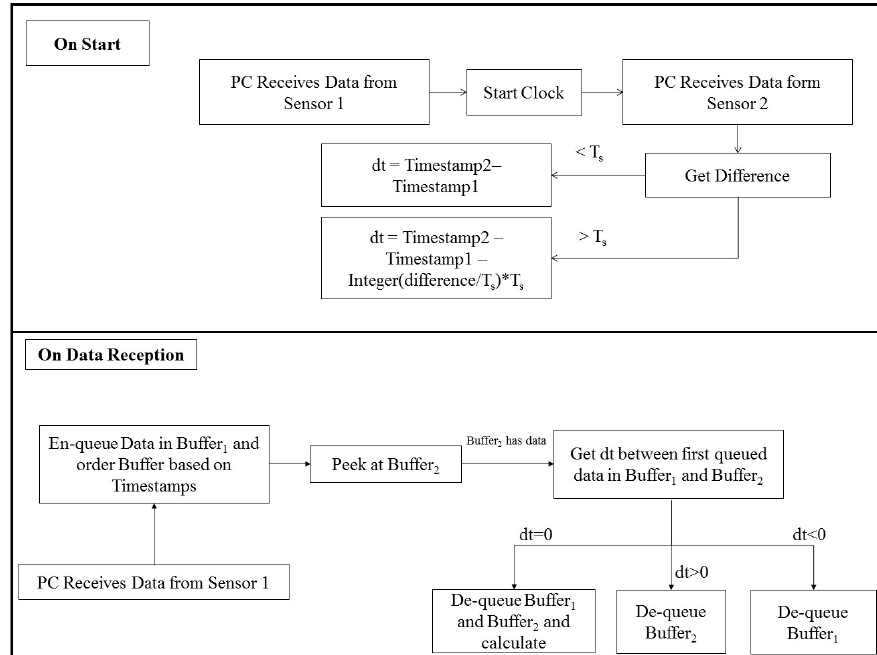
Figure 2. Data flow of sensor synchronization algorithm.